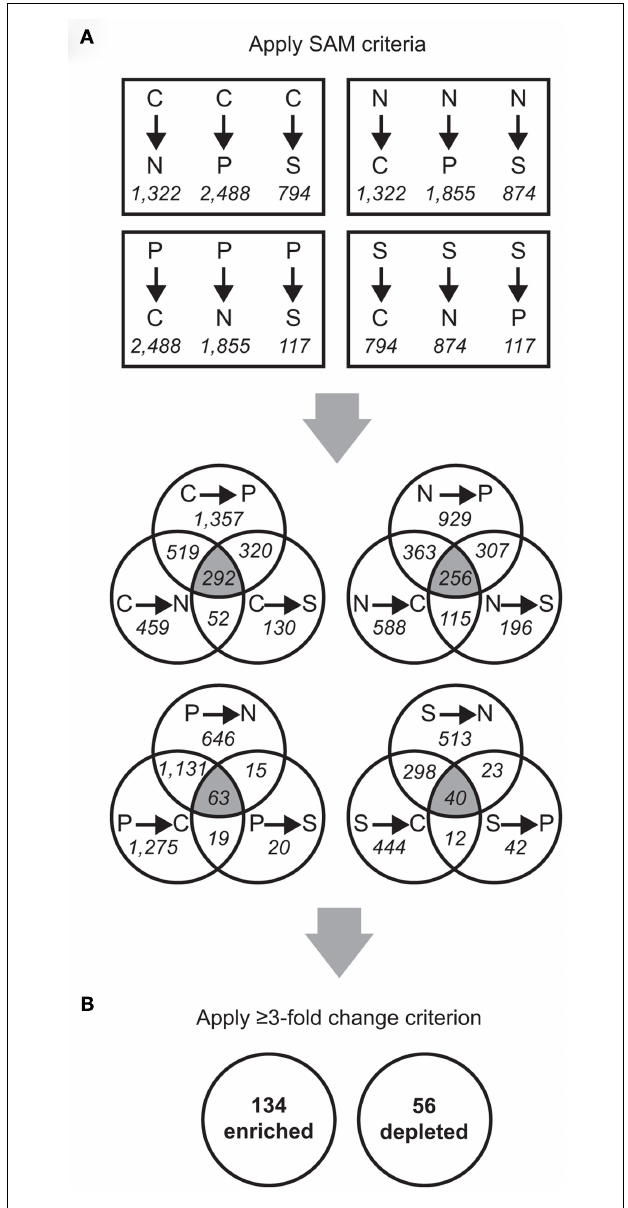
FIGUREA1 | Schematic of microarray data analysis. Probe counts are shown in italicized font and gene counts are in bold font. (A) Significant Analysis of Microarray (SAM) was used to analyze the microarray data (pairwise SAM comparisons with 5,000 permutations and a false discovery rate ≤ 2%). From these results, probes significantly different in all three comparisons to the other treatments (that is, falling into the three-way overlap region of eachVenn diagram) were selected for further analyses. (B) From the normalized fluorescence values, the fold-change for each probe was calculated as the median value between all limitation-to-excess pairwise comparisons and genes whose fold-change was ≥ 3 were